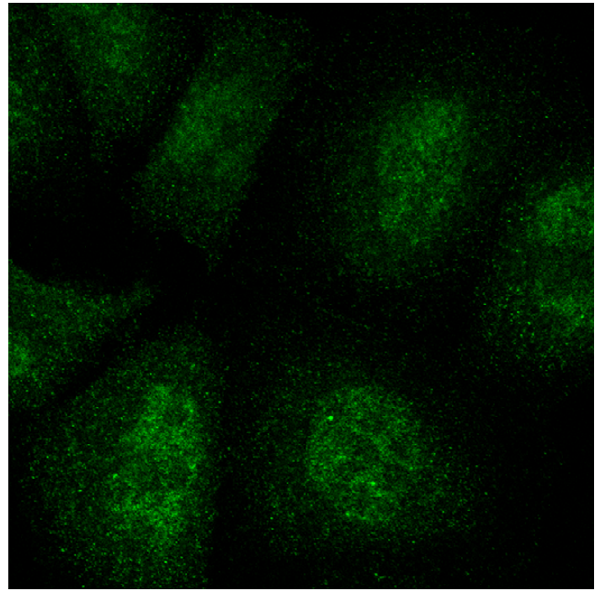
Figure 4. Example of detection of mixed patterns by clustering. Protein ‘‘nerve growth factor receptor’’ was visually annotated as ‘‘cytoplasm’’, but was annotated as ‘‘nucleus without nucleoli’’ mixed with ‘‘cytoplasm’’ by clustering in the first round. The latter annotation was chosen after re-examination.